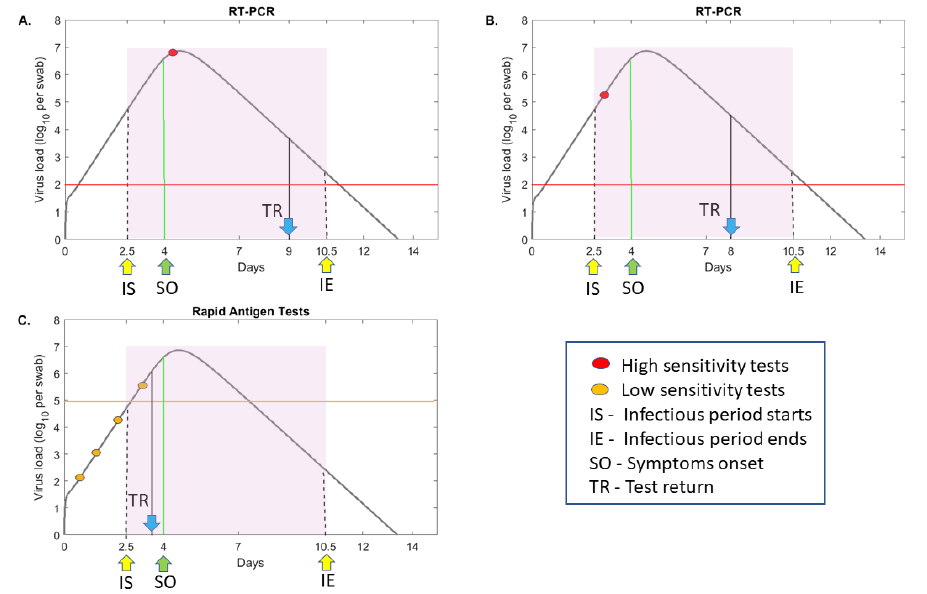
Figure 1. RT-PCR versus rapid testing practices. log virus load per swab over time as given by 10 model (1) (grey curves) for values in [26]. Patients are assumed to be infectious from t = 2.5 days (IS) till t = 10.5 days (IE) (shaded region) and symptomatic beginning on day t = 4 (SO). Panels ( A ) ( V ) = 2 per and ( B ) depict testing with a high-sensitivity RT-PCR test with detection threshold log 10 swab (red line) and test return delay of five days. In panel A, the test occurs immediately following symptoms onset, and in panel B, the test occurs before symptoms onset (red circles). Panel C depicts ( V ) = 5 per frequent testing (yellow circles) with a low-sensitivity test with detection threshold log 10 swab (yellow line) and test return delay of one half day. TR shows the time of positive test